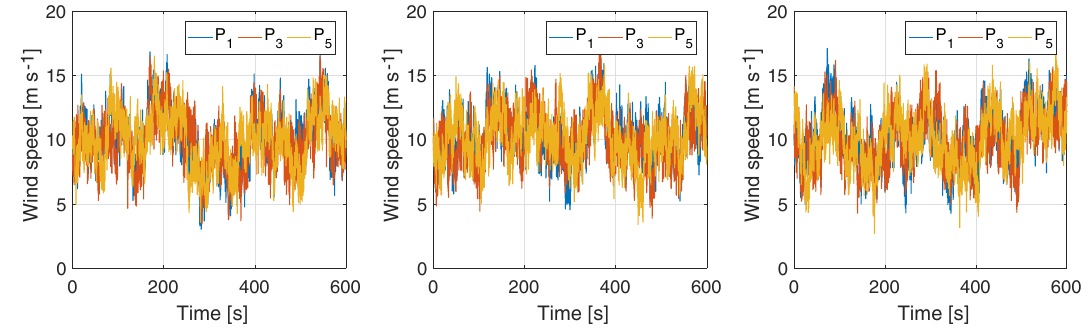
Figure 6. Three realizations of wind speed time series at three points generated from the new reduced-order model with fixed phase incre- ments (Veers red ,(cid:49)θ ).